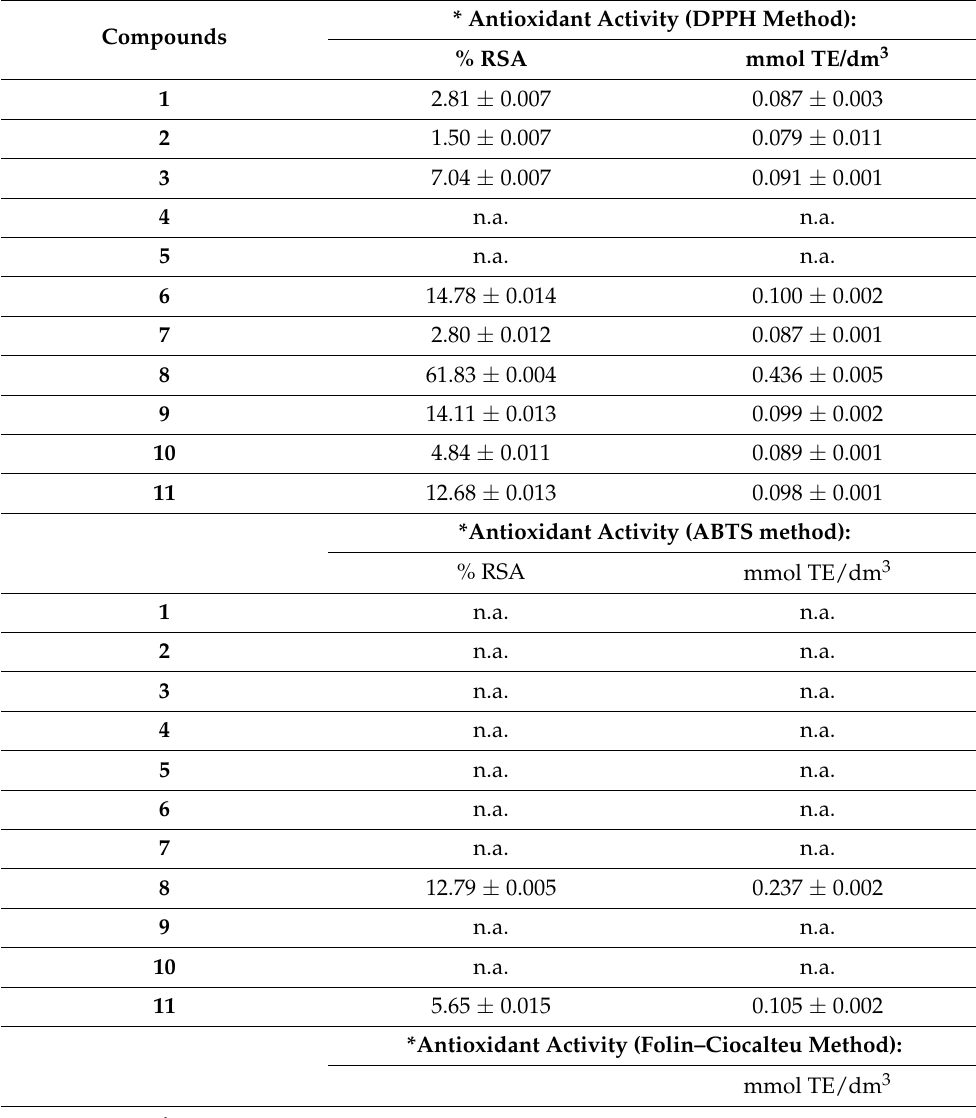
Table 2. Antioxidant activity of betulin and its derivatives.